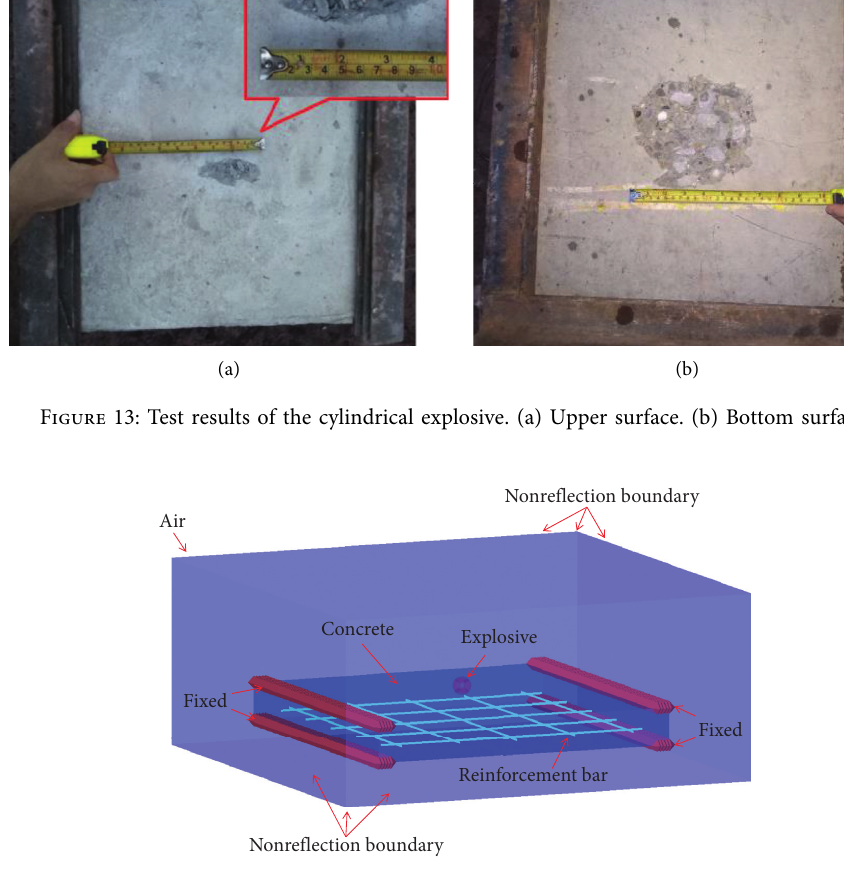
Figure 14: Geometry model of the RC slab subjected to air contact